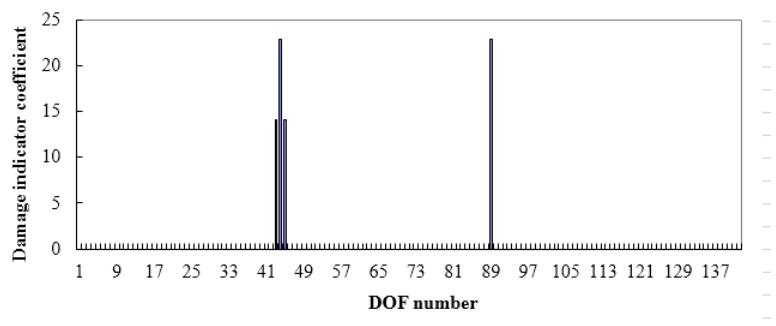
Figure 4. Damage indicator vector when short cable 15 was damaged.